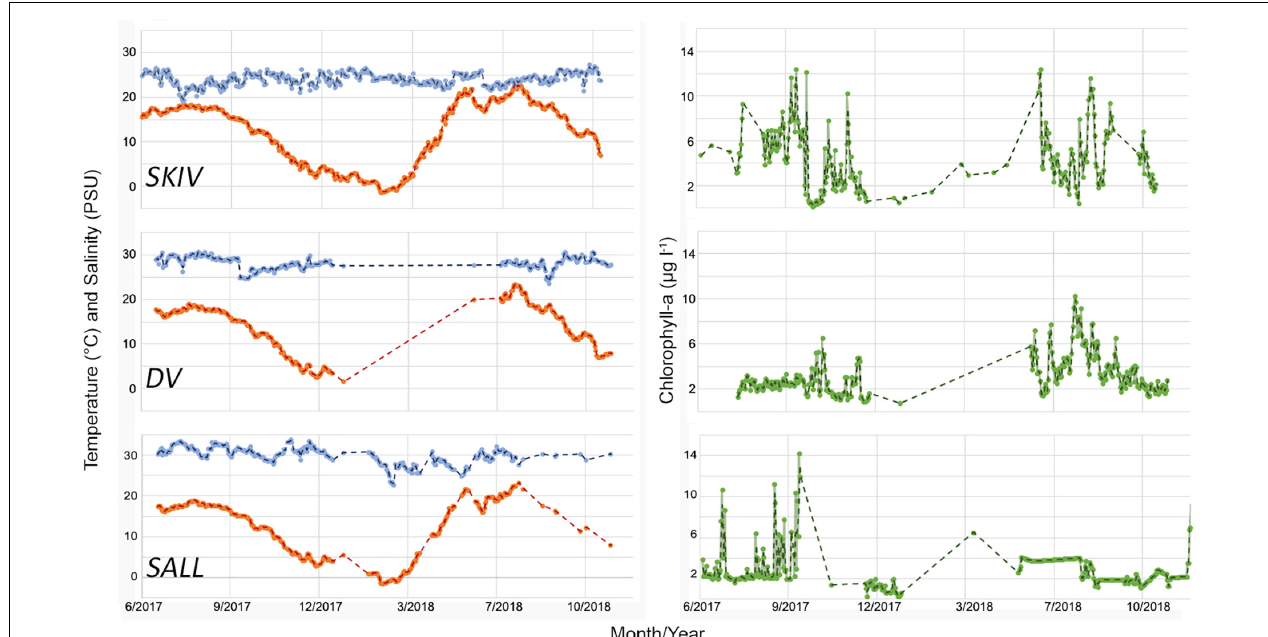
FIGURE 3 | Time series of environmental conditions at each site from continuous monitoring at 2 m depth. Left panel: orange = temperature ( ◦ C), blue = salinity (PSU). Right panel: green = chl-a ( µ g l − 1 ).